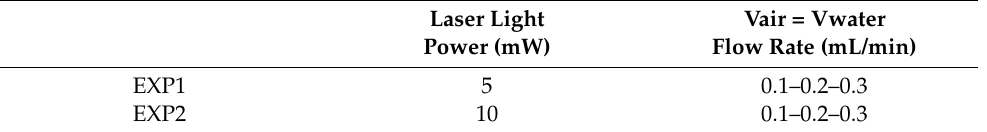
Table 2. Experimental campaigns carried out, varying the power of the laser used to light the process and the hydrodynamic pressure, for both the PDMS mofd and ZnO-PDMS mofd for both fluid combinations of air–water (FLOW1) and air–glycerol–water